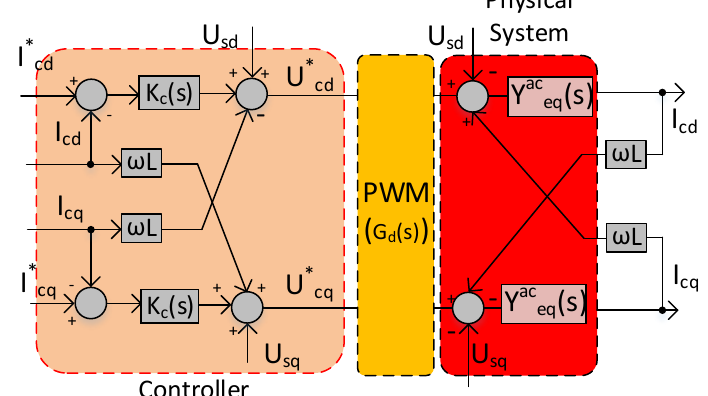
Figure 3. Inner current loop and physical